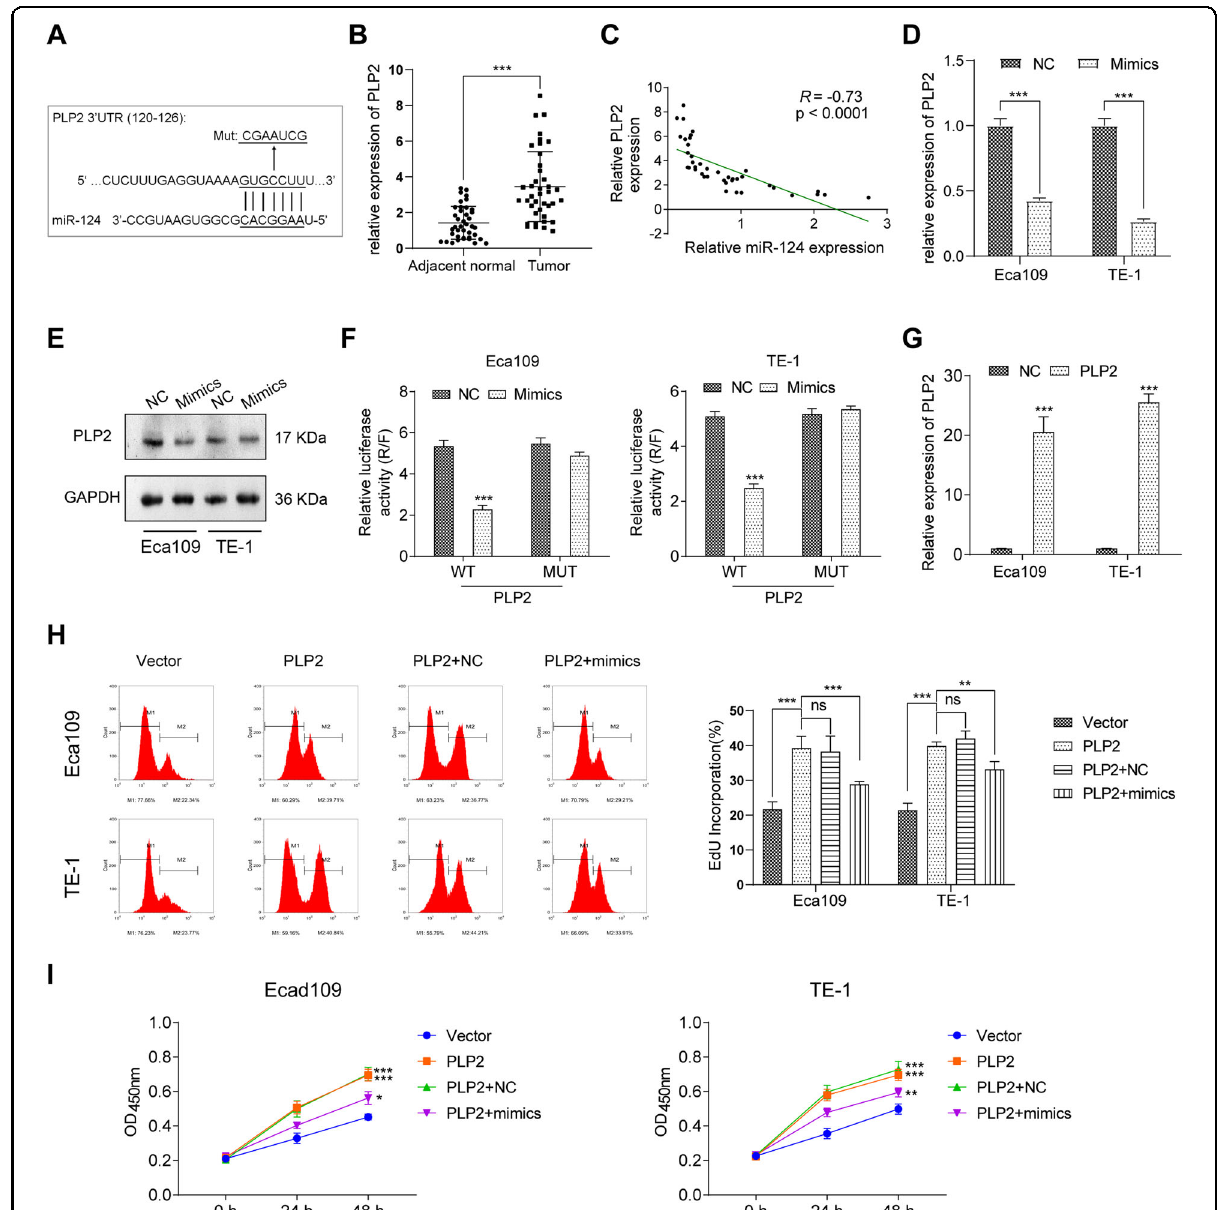
Fig. 4 Oncogene PLP2 was the target gene of miR-124 and promoted ESCC cell growth. A PLP2 was predicted to harbor the potential interaction sites of miR-124 by bioinformatics analysis. B The expression of PLP2 in ESCC tissues and adjacent normal tissues was determined by RT- qPCR. C The correlation of the miR-124 expression and PLP2 expression in ESCC tissues. D , E Overexpression of miR-124 inhibited the mRNA and protein expressions of PLP2 in Eca109 and TE-1 cells. F Luciferase reporter assay indicated that PLP2 was a target gene of miR-124. G The PLP2 expression in Eca109 and TE-1 cells after PLP2 overexpression. H The proliferation and I viability of Eca109 and TE-1 cells determined by Edu assay and CCK-8 assay. *** p <